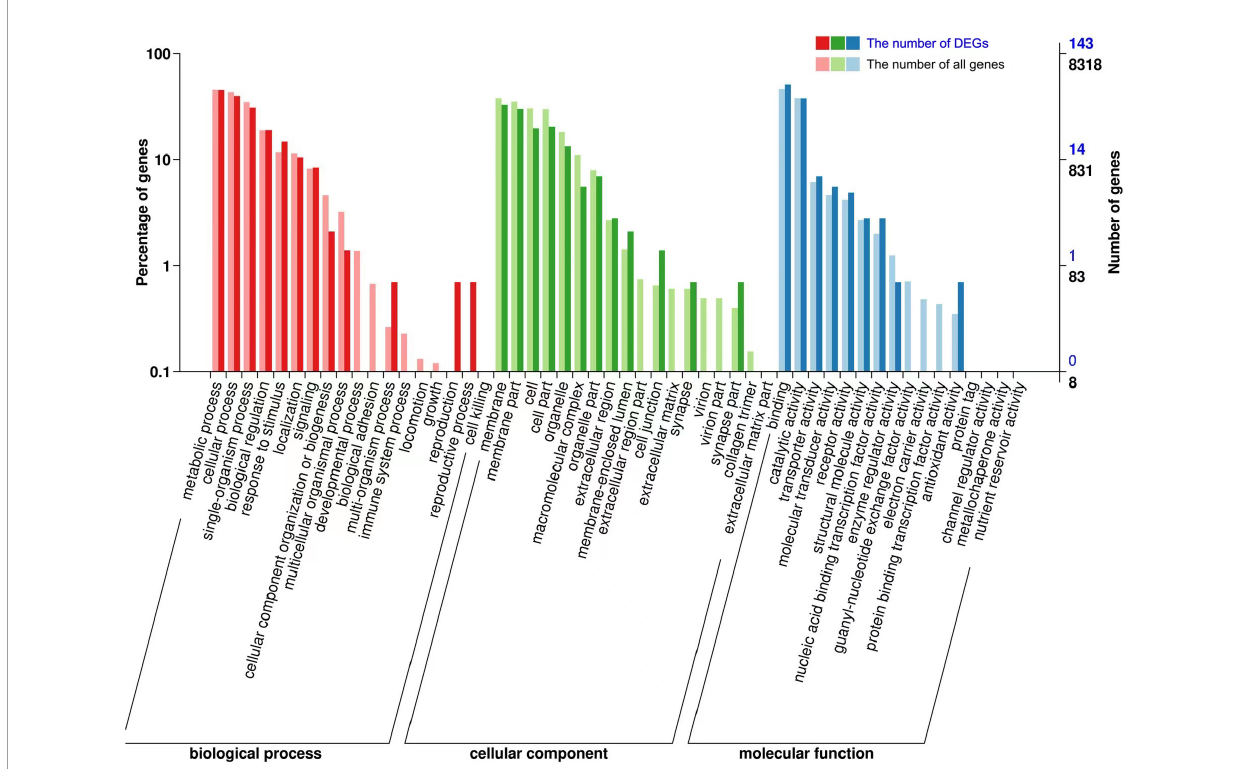
FIGURE4 Gene Ontology (GO) enrichment analysis of DEGs. The X -axis indicates the GO classification, the left side of the Y -axis indicates the percentage of genes, and the right side shows the number of genes. Bold colors indicate the number of DEGs, and light colors indicate the number of all genes.